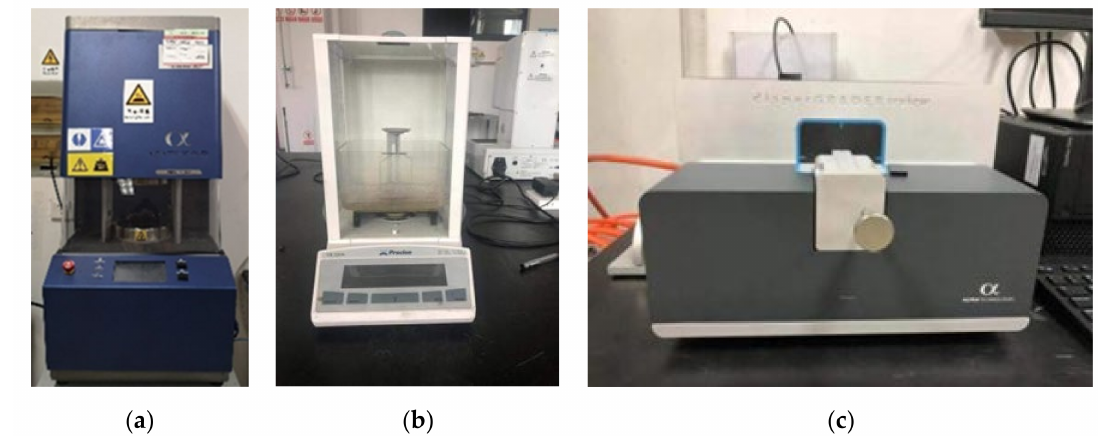
Figure 18. Photos of ( a ) Mooney viscosity, ( b ) hydrometer, and ( c ) carbon black dispersion